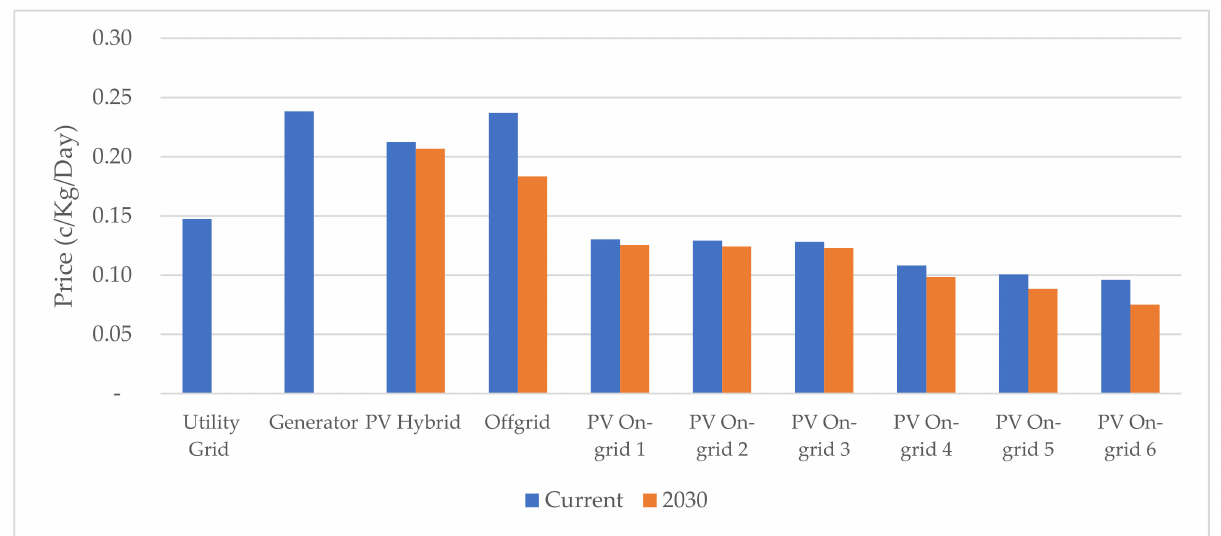
Figure 15. Rental Prices for Commercial-based Cold Storage in